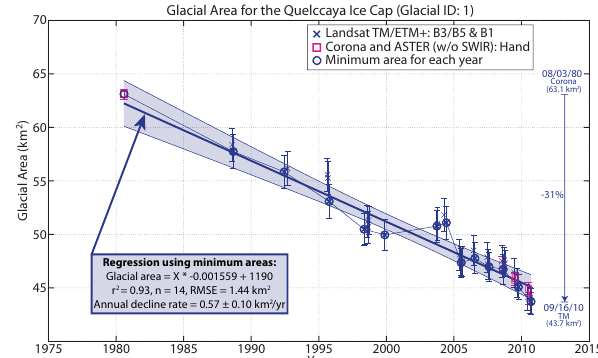
Fig. 8. (a) Hillshade topography showing the location of the iden- tified glacierized regions (G n ) and lakes (L n ) for which results are presented in this study (including the Supplement). Glacierized re- gions are white (outlined by thin black lines), while lakes are blue (not all 50 lakes are shown here). All glacierized regions have been named after the dominant peak in that region, with the exception of G2, the extent of which is outlined by the dashed white line. The acronym NA for G3 stands for Nevado Ausangate. Additionally, the thick black line outlines the approximate extent of the Cordillera Vilcanota. Note that Nevado Allincapac (G8) is the only glacierized region located beyond the CV. The red box outlines the extent of the QIC in (b) , which shows the QIC’s earliest and most recent glacial outlines and illustrates all polygons we have included in the QIC extent in this study ( entire area) and also what we refer to as the main area. The locations of lakes for which results are presented in this study are indicated, as are three glacial watersheds within which these lakes are located.